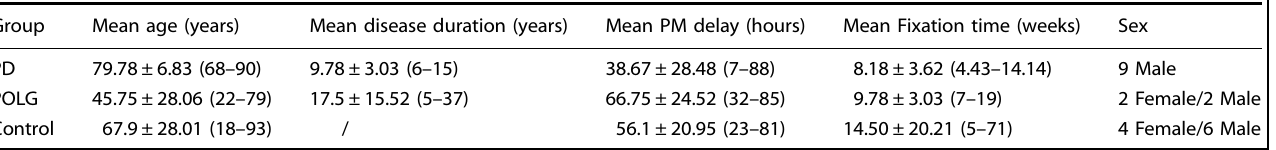
Table 3. Summarized information for cases included in this